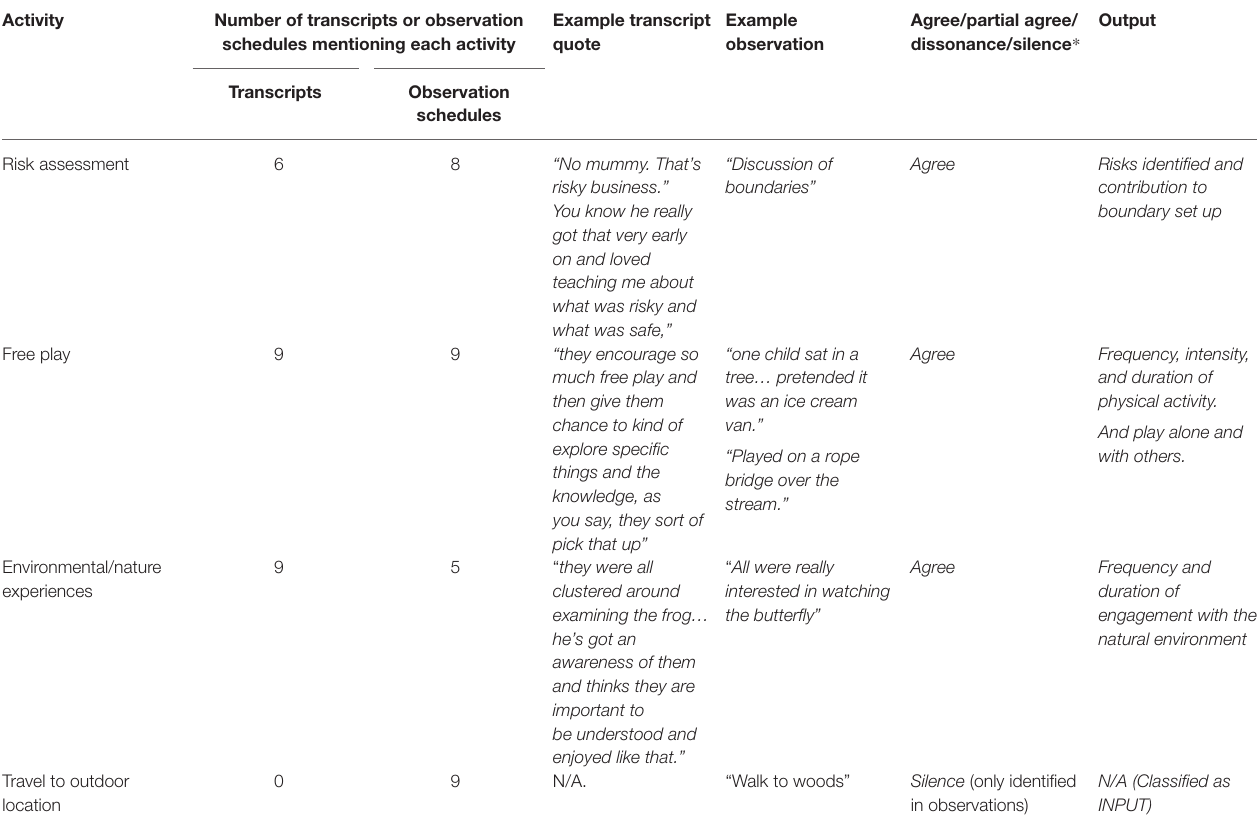
TABLE 2 | Extract from triangulation of transcript and observation schedule analysis to determine activities to be included in the logic model.